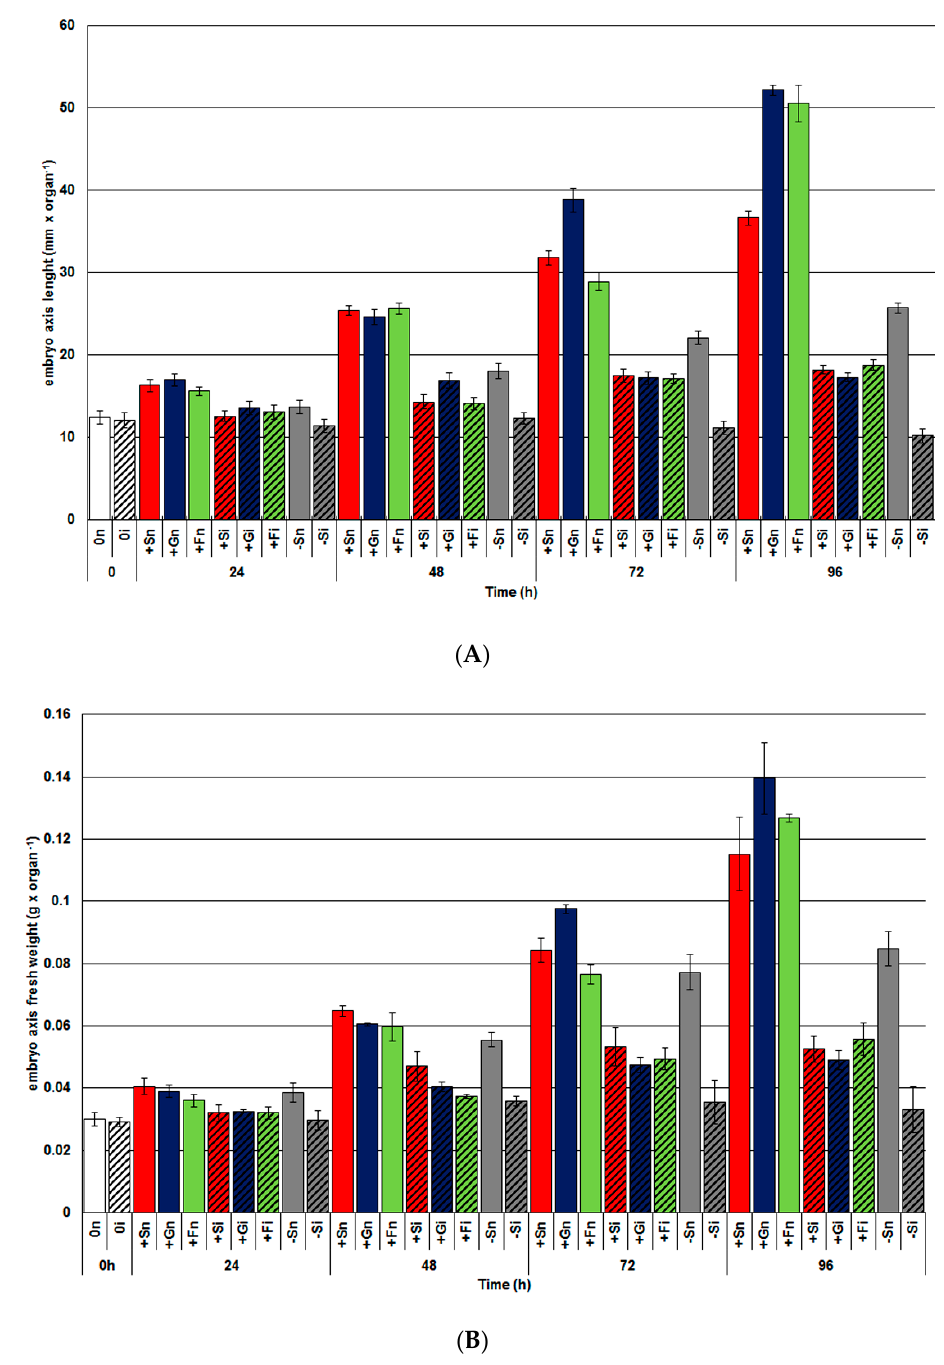
Figure 5. Effects of sucrose, glucose, and fructose on the growth (( A ) length and ( B ) fresh weight) of cultured in vitro embryo axes of Lupinus luteus infected with Fusarium oxysporum f. sp. lupini . ( + Sn, non-inoculated embryo axes and cultured in vitro on Heller’s medium with 60 mM sucrose; + Gn, non-inoculated embryo axes and cultured in vitro on Heller’s medium with 120 mM glucose; + Fn, non-inoculated embryo axes and cultured in vitro on Heller’s medium with 120 mM fructose; − Sn, non-inoculated cultured in vitro on medium without sucrose; + Si, inoculated and cultured with 60 mM sucrose; + Gi, inoculated and cultured with 120 mM glucose; + Fi, and with 120 mM fructose; − Si, inoculated and cultured without sucrose). A summary of the statistical significance of differences between the average values of each pair at p < 0.05 can be found in the Supplementary Files (Table S4).